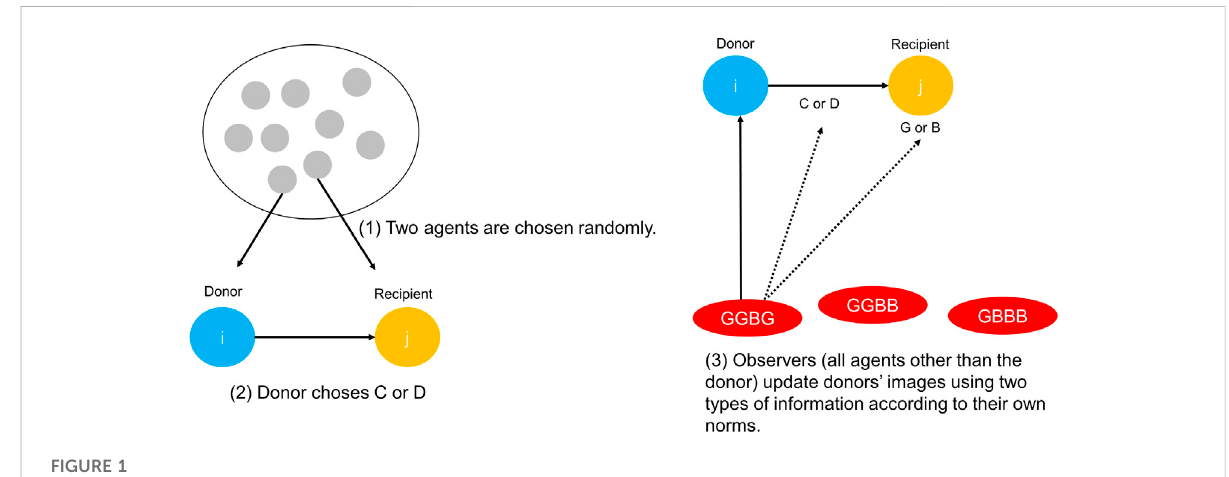
FIGURE 1 Overview of the game.